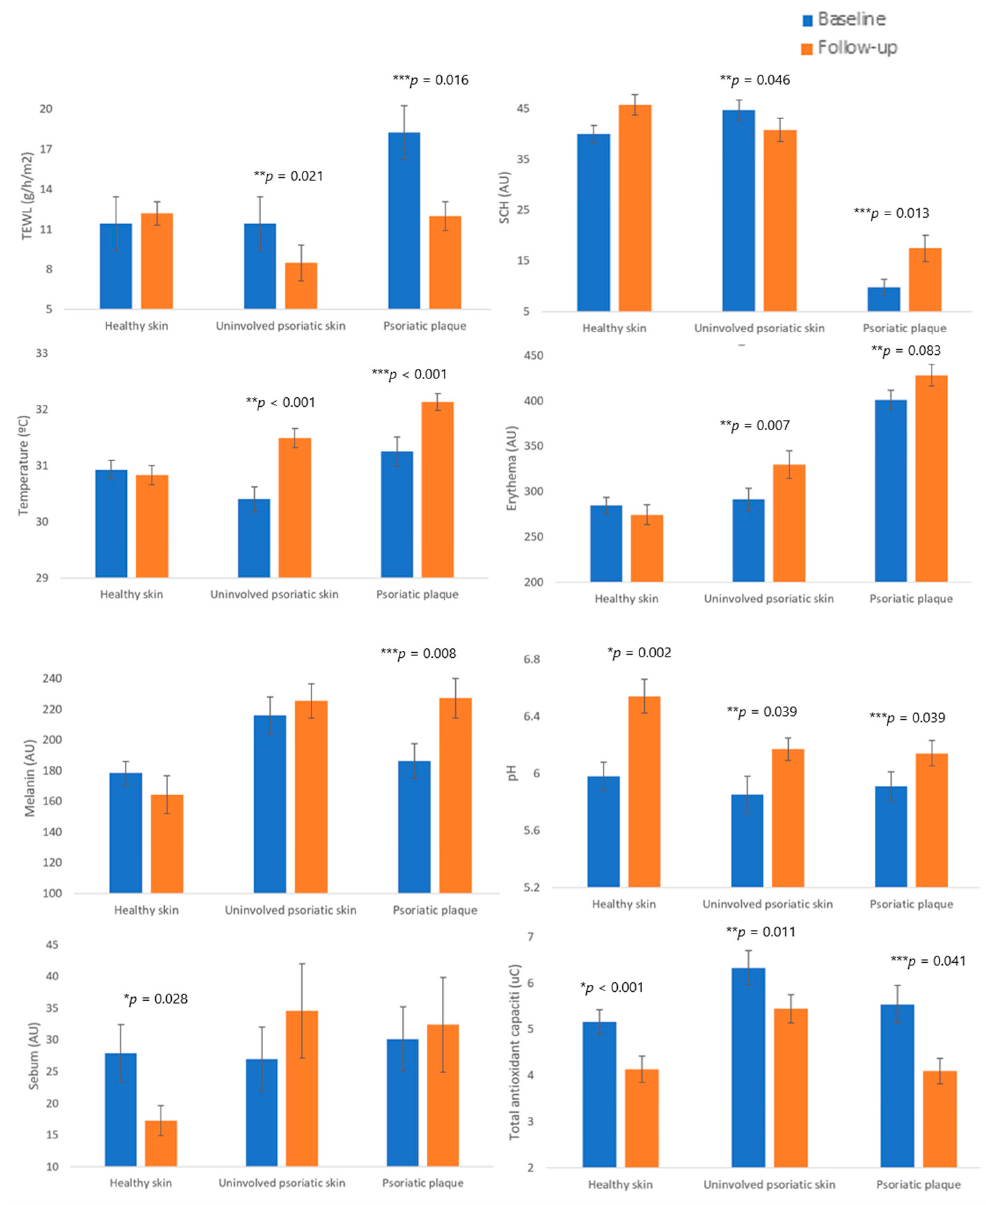
Figure 1. Homeostasis skin parameters in healthy skin, uninvolved psoriatic skin, and psoriatic plaques before and after follow-up. AU, arbitrary units; SCH, stratum corneum hydration; TEWL, transepidermal water loss; uC, microcoulombs. * p- value after using a linear regression model adjusted by emollient use to compare homeostasis parameters between control and uninvolved psoriatic skin before phototherapy. ** p- value after using a linear regression model adjusted by emollient use to compare homeostasis parameters between control and psoriatic plaques before phototherapy. *** p- value after using Student’s t -test for paired samples to compare homeostasis parameters between uninvolved psoriatic skin and psoriatic plaques before phototherapy. Only p -values of <0.05 are shown.